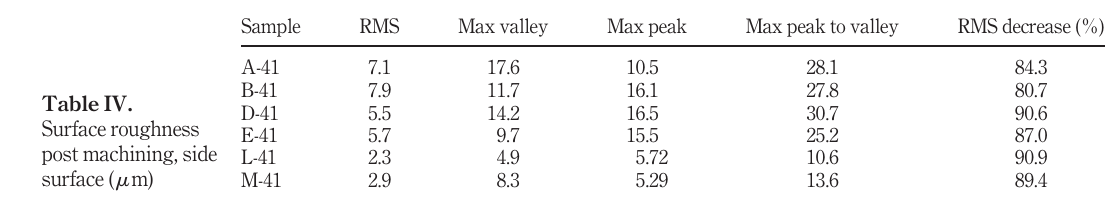
Table III. Surface roughness post machining, top surface ( m